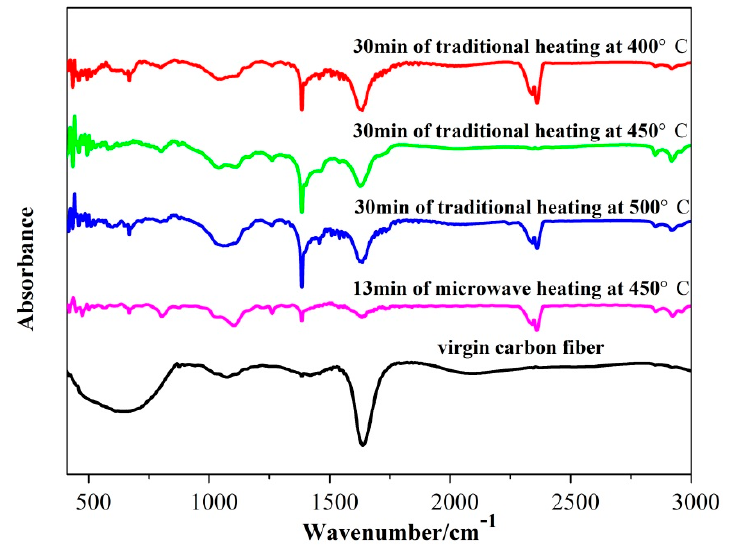
Figure 6. Fourier transform infrared (FT-IR) spectra of carbon fibers.